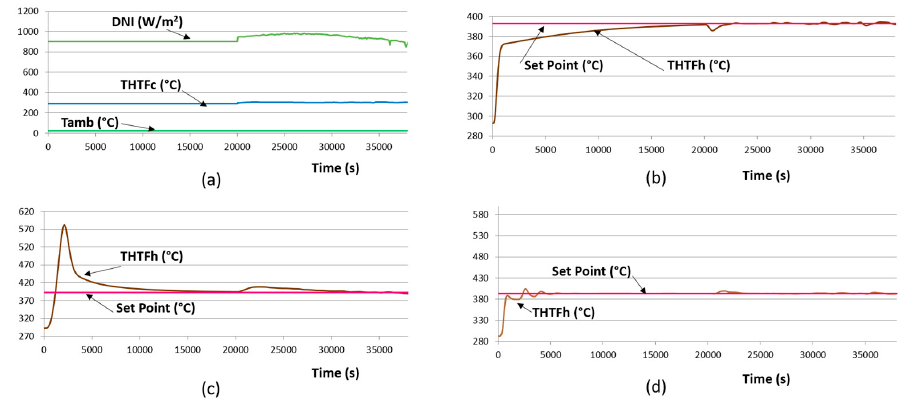
Figure 9. Results obtained for the different algorithms using real data, September 2010. DNI, ambient temperature, and HTF temperature at the solar field input ( a ); HTF temperature for the PID-FF ( b ); PID ( c ); and ADEX ( d ) regulators.